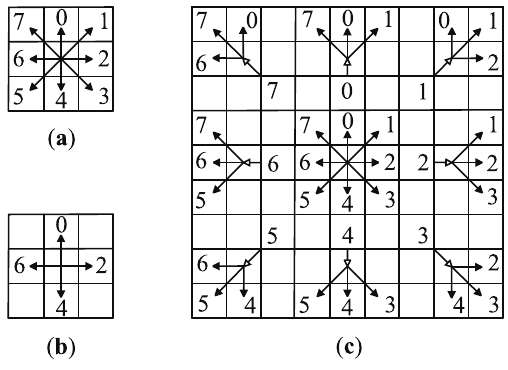
Figure 1. OC of motion: ( a ) 8OC; ( b ) 4OC; ( c )